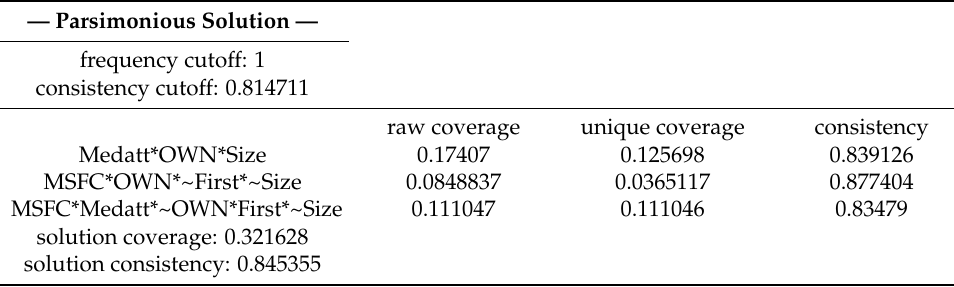
Table 5. Simple solution of fsQCA output (consistency: 0.8).